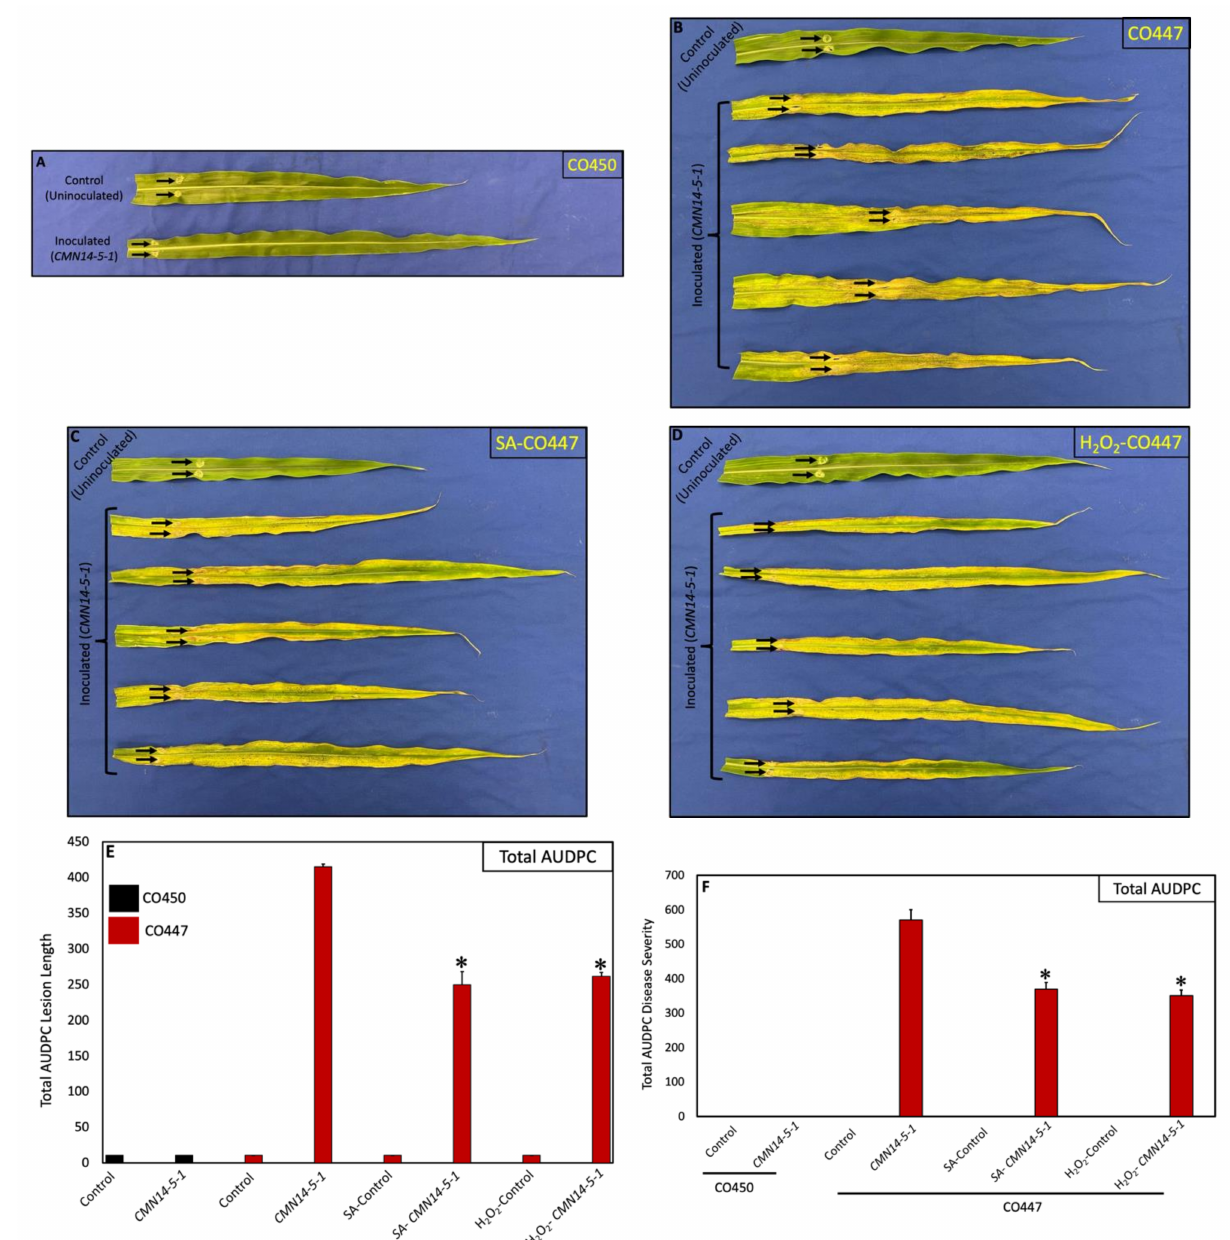
Figure 4. SA and H 2 O 2 confer partial disease resistance to C. nebraskensis (CMN14-5-1) in the susceptible CO447 corn line. ( A – D ) Phenotype of the tested corn plants. Wounded tolerant CO450 ( A ) and susceptible CO447 ( B ). Plants were pretreated with either the PPB buffer (control) or the aggressive CMN14-5-1. Control leaves were treated with 20 µ L of buffer, and inoculated leaves were inoculated with the bacterial suspension. Arrows point to the inoculation site. Local defense response in the susceptible CO447 plants pretreated with SA ( C ) or H 2 O 2 ( D ) (500 µ M each). The tested plants were inoculated with CMN14-5-1 48 h after local treatments. ( E ) The AUDPC for lesion lengths was calculated for control and inoculated CO447 plants pretreated with SA or H 2 O 2 . ( F ) Disease severity progression in CO447 plants pretreated with SA or H 2 O 2 . The values are the average of the AUDPC values for 12 biological replicates at 7 and 14 days after inoculation, based on a disease severity scale of 0 to 6. The error bars represent the standard error. Asterisks denote significant differences of the treated inoculated CO447 plants relative to the inoculated CO447 plants; * p <